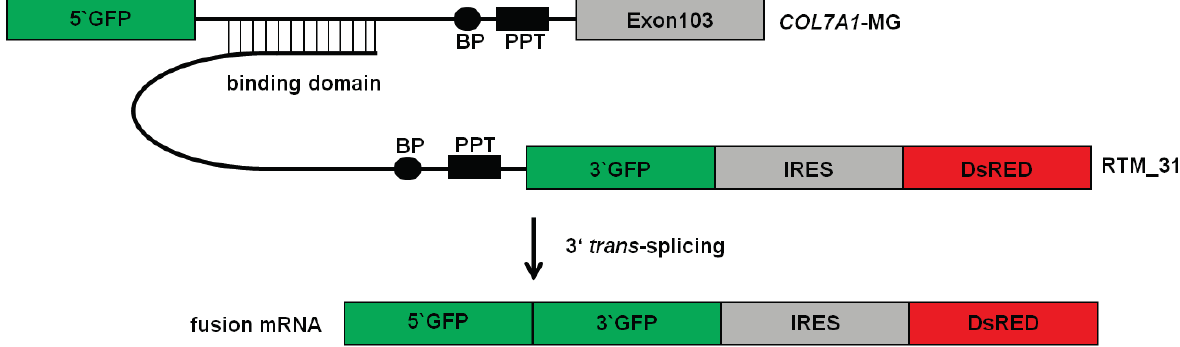
Figure 1. RNA trans -splicing molecules (RTMs) screening system and binding position of RTM_31 within COL7A1 intron 102/exon 103. The fluorescence-based model system consists of a COL7A1 -minigene ( COL7A1 -MG), carrying the 5' portion of GFP upstream of the RTM binding region intron 102/exon 103 of COL7A1 and RNA trans -splicing molecules carrying a BD (binding domain) specific for intron 102 of COL7A1 , a splicing domain (including branch point, BP; polypyrimidine tract, PPT; 3' acceptor splice site, ss), the missing portion of 3' GFP, an internal ribosomal entry site (IRES) and the reporter molecule, DsRED. Accurate trans -splicing between the COL7A1 -MG and a functional RTM leads to fusion of both GFP parts provided by both interacting molecules, thereby restoring the function of the